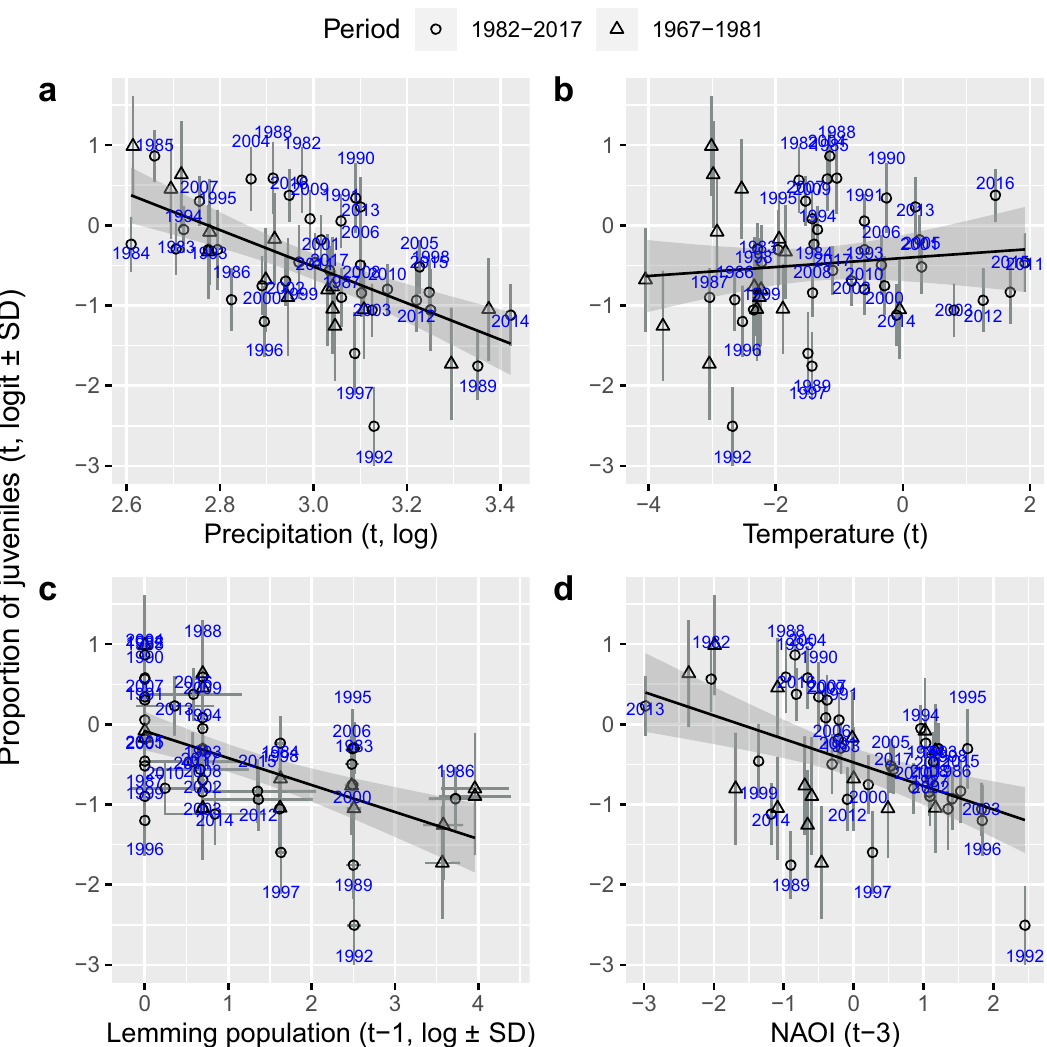
Figure 3. Juvenile proportion of long-tailed ducks from Danish hunting returns in relation to North-western Siberian weather in May and June: ( a ) precipitation and ( b ) temperature, ( c ) estimated lemming abundance in the Western Taimyr Peninsula in the previous year, and ( d ) North Atlantic Oscillation Index (NAOI) three years before. Numbers indicate the year (1982–2017) of the observed data point and circles show the corresponding estimates based on Eq. (2). Triangles show estimates for the period 1967–1981 from which no observations were available (the proportion of juveniles as conditioned on all other data and parameters in the Bayesian